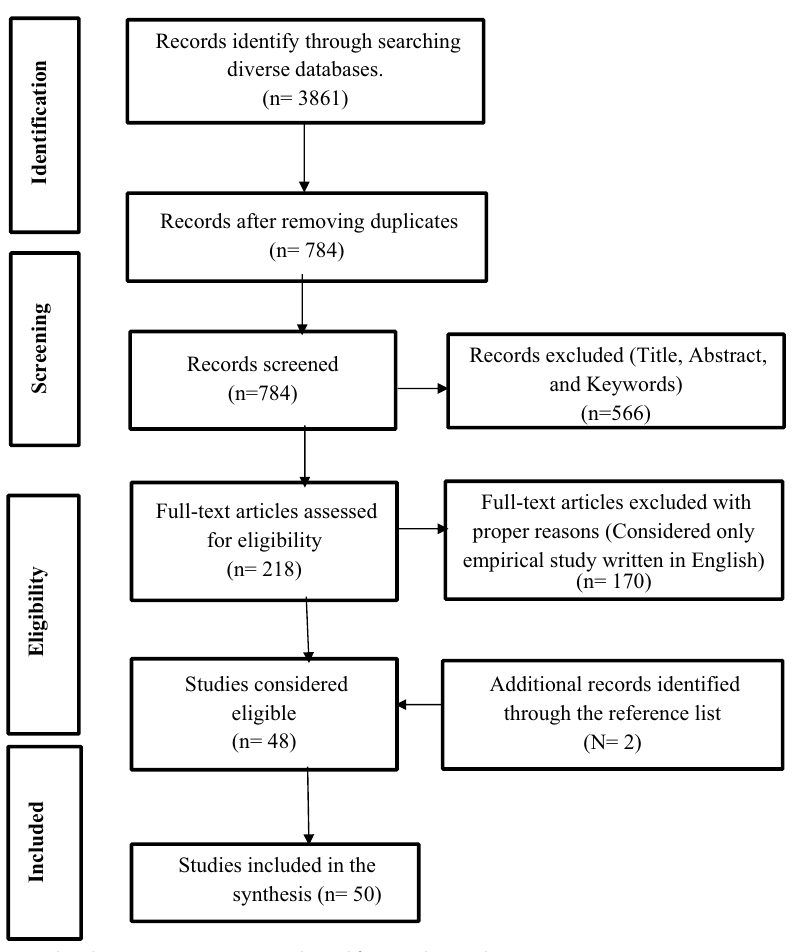
Fig. 2 Article selection process. Source: Adapted from Moher et al. (2009)